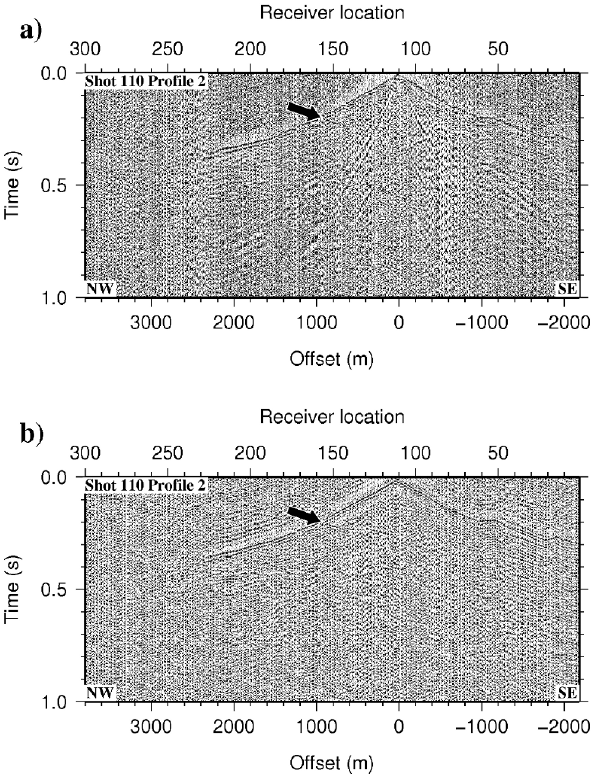
Fig. 5. (a) Raw shot-gather (agc 100ms window and high pass filter (10 20) was used) from S.P. 2. (b) The same shot-gather processed until step 10 + step 12 and 17. Black arrow marks reflection more clearly seen in the processed shot-gather.